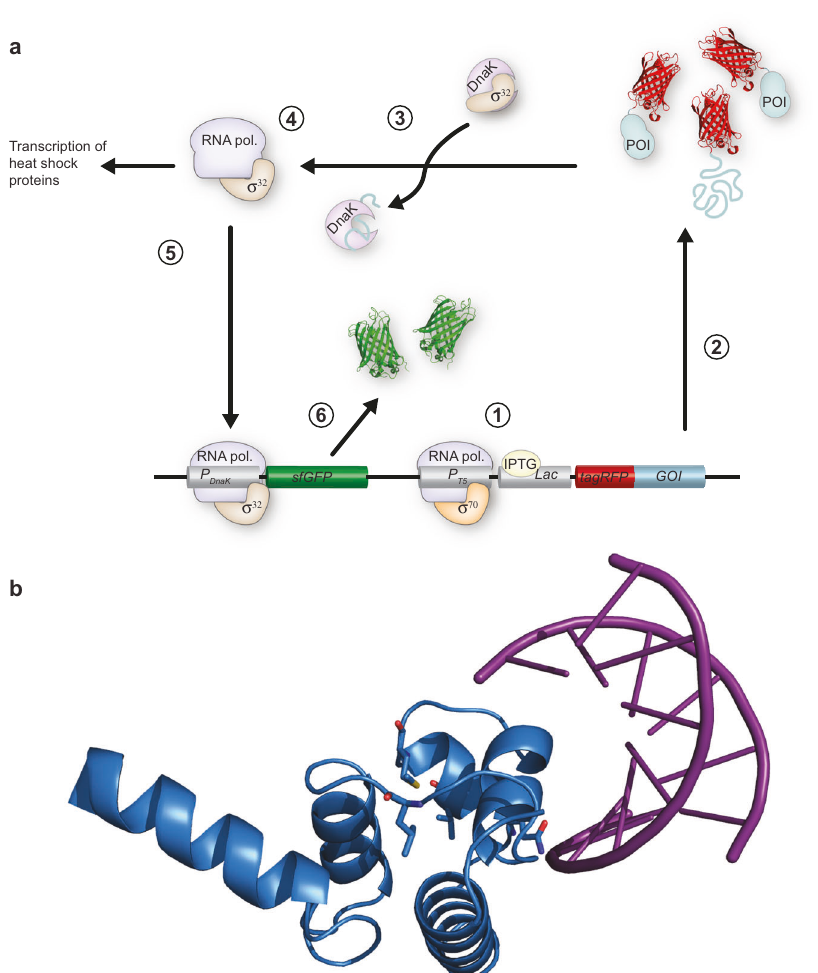
Fig. 1 A fl uorescent-based reporter system for protein abundance and DnaK response. a Overview of reporter system: (1) The addition of IPTG allows for transcription of the GOI (gene of interest)-tagRFP by RNA polymerase in a complex with the transcription factor σ 70 . (2) Following transcription of GOI- tagRFP the protein of interest, POI-tagRFP is synthesised. (3) DnaK releases the transcription factor σ 32 and binds to unfolded/misfolded POI-tagRFP. (4) σ 32 binds to RNA polymerase. (5) Binding of σ 32 to RNA polymerase allows for transcription of endogenous PQC proteins, such as DnaK. The RNA polymerase — σ 32 complex will also bind to the DnaK promoter on the reporter plasmid and transcribe the sfGFP gene. (6) Following transcription of the sfGFP gene, the protein sfGFP will be synthesised. b The N-terminal domain of the λ repressor (blue) bound to DNA (purple). Mutated residues are shown as sticks (blue). PDB:1lmb 56